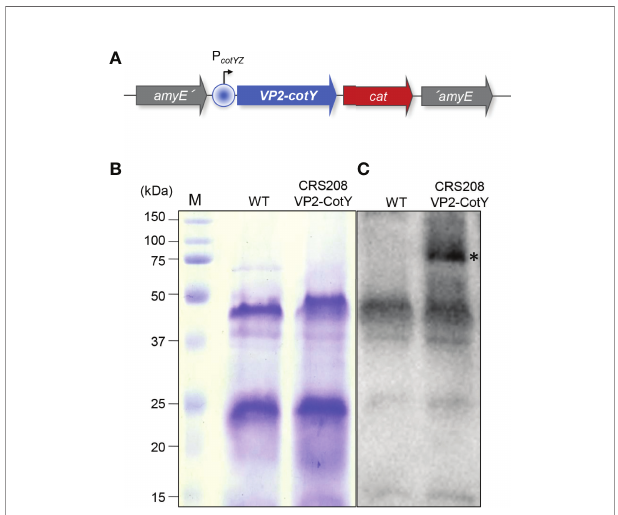
FIGURE 1 | (A) Schematic representation of the CRS208 genotype. The VP2- encoding gene was translationally fused to the spore protein-encoding gene cotY , under the control of the cotYZ promoter, and integrated at the non-essential amyE locus of B. subtilis 168, creating the CRS208 strain. (B) Spore proteins from the parental strain B. subtilis 168 (WT) and its congenic derivative CRS208 were separated in a 15% acrylamide gel with 6 M of urea, revealing a similar pattern. (C) Western blot analysis using an anti-VP2 primary antibody (1:1000) detected a band of approximately 74 kDa (highlighted by an asterisk) equivalent to the sum of the MW of CotY (18 kDa) and VP2 (56 kDa), that was absent in the protein extracts from WT